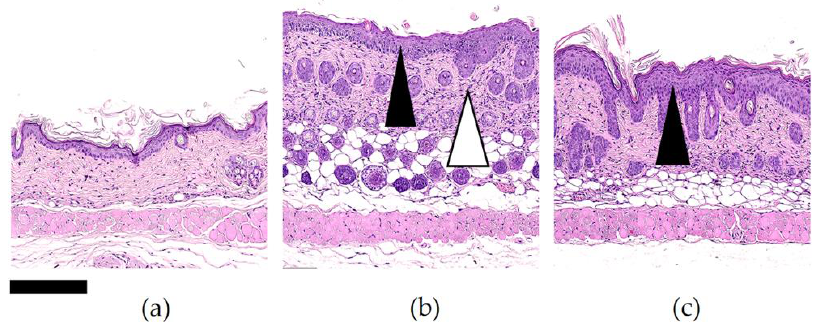
Figure 7. Representative microphotographs of skin (dorsum) of mice previously ( a ) treated with Dermovate ® ; ( b ) emulsion placebo; ( c ) AAN-16 E. Changes were characterized by epidermal hyperplasia (black arrowhead), and focally extensive inflammation expanding the dermis (white arrowhead). Hematoxylin and eosin stain. Original magnification, 10× (bar, 250 µm). Histopathological changes were evaluated by means of epidermal and dermal thickness.